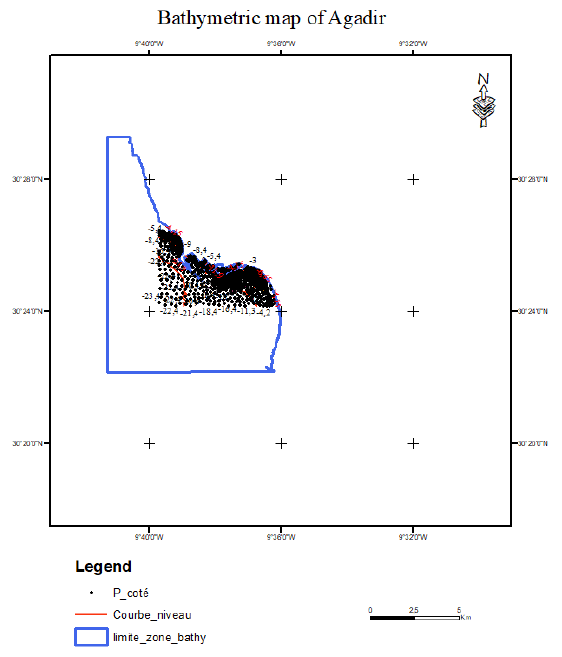
Figure4 . Bathymetric data of the Agadir area